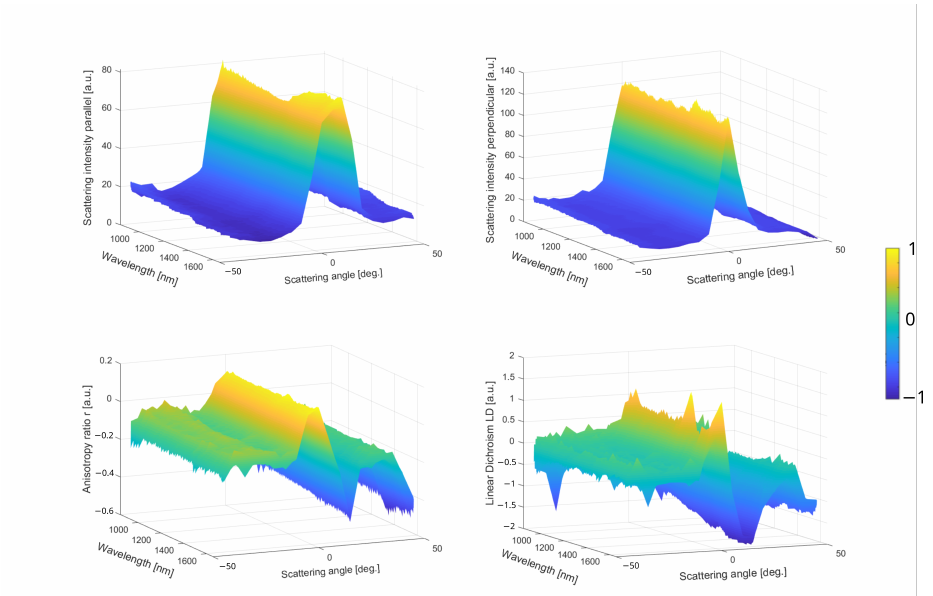
Figure 3. Multiparametric scattering sensing of starch granules from potatoes. ( Top row ) Raw parallel and perpendicular spectra in function of the scattering angle. ( Bottom row ) The r and LD spectra in function of the scattering